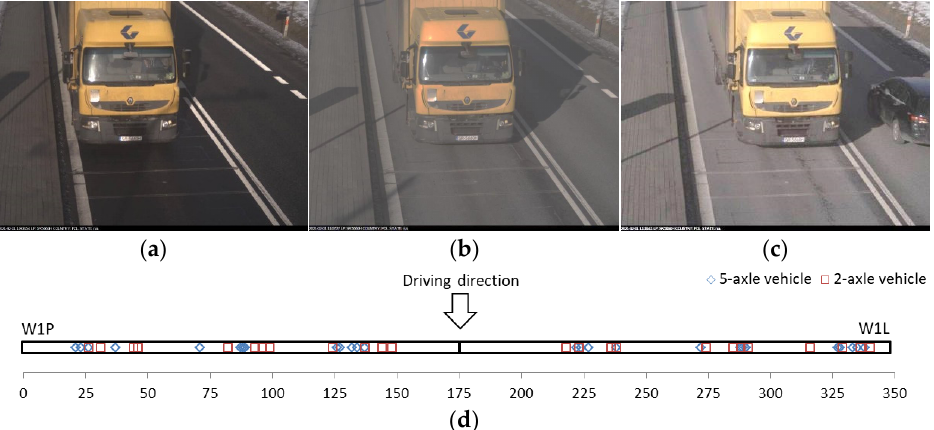
Figure 12. Control runs ( a ) right side, ( b ) central, ( c ) left side, and ( d ) position of tyre-sensor con-